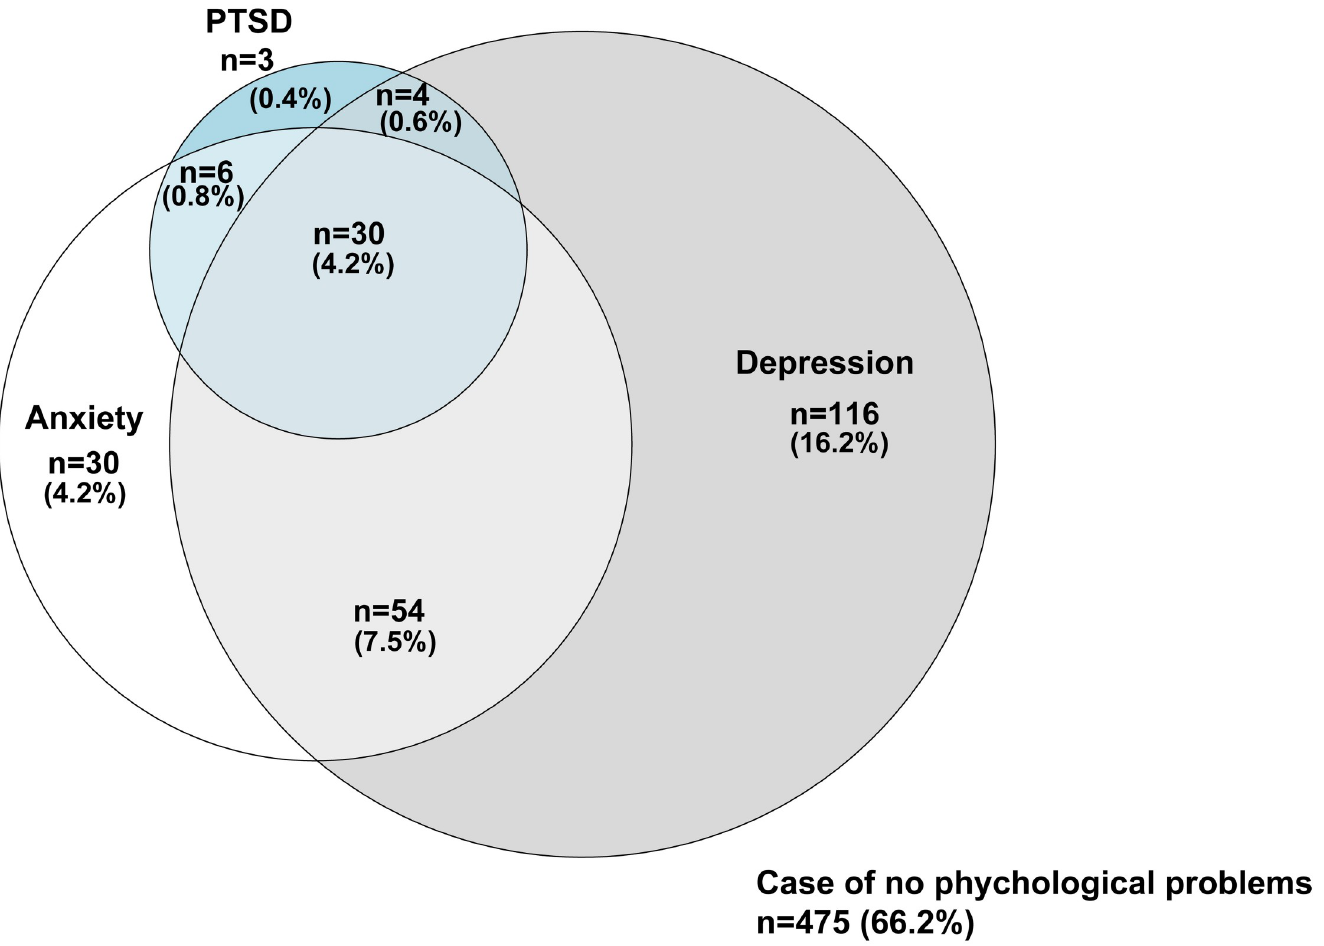
Fig 4. Venn diagram for PTSD, anxiety, and depression in patients living at home one year after discharge from the intensive care unit. PTSD, post-traumatic stress disorder.